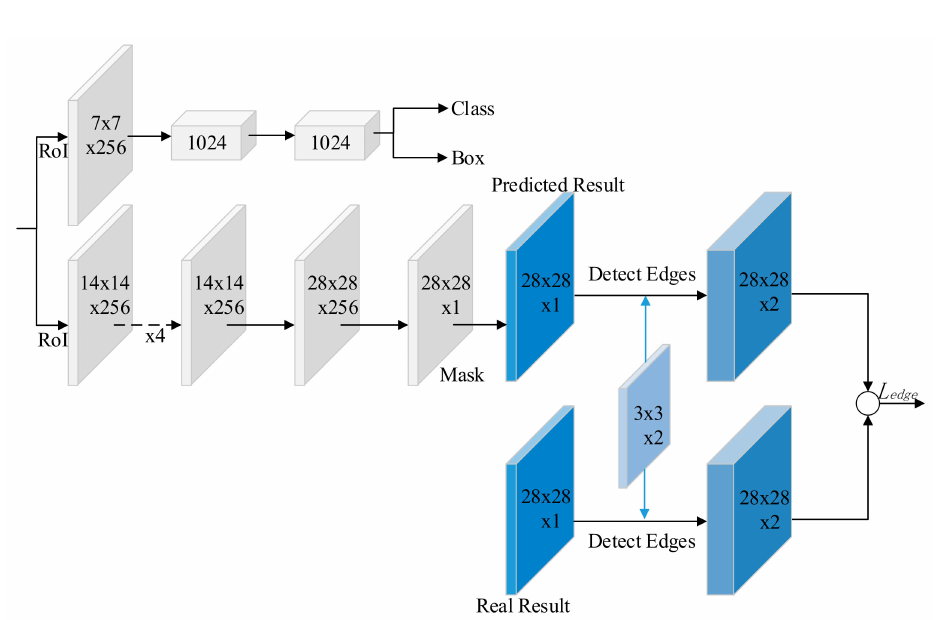
Figure 5. Edge consistency error calculation auxiliary